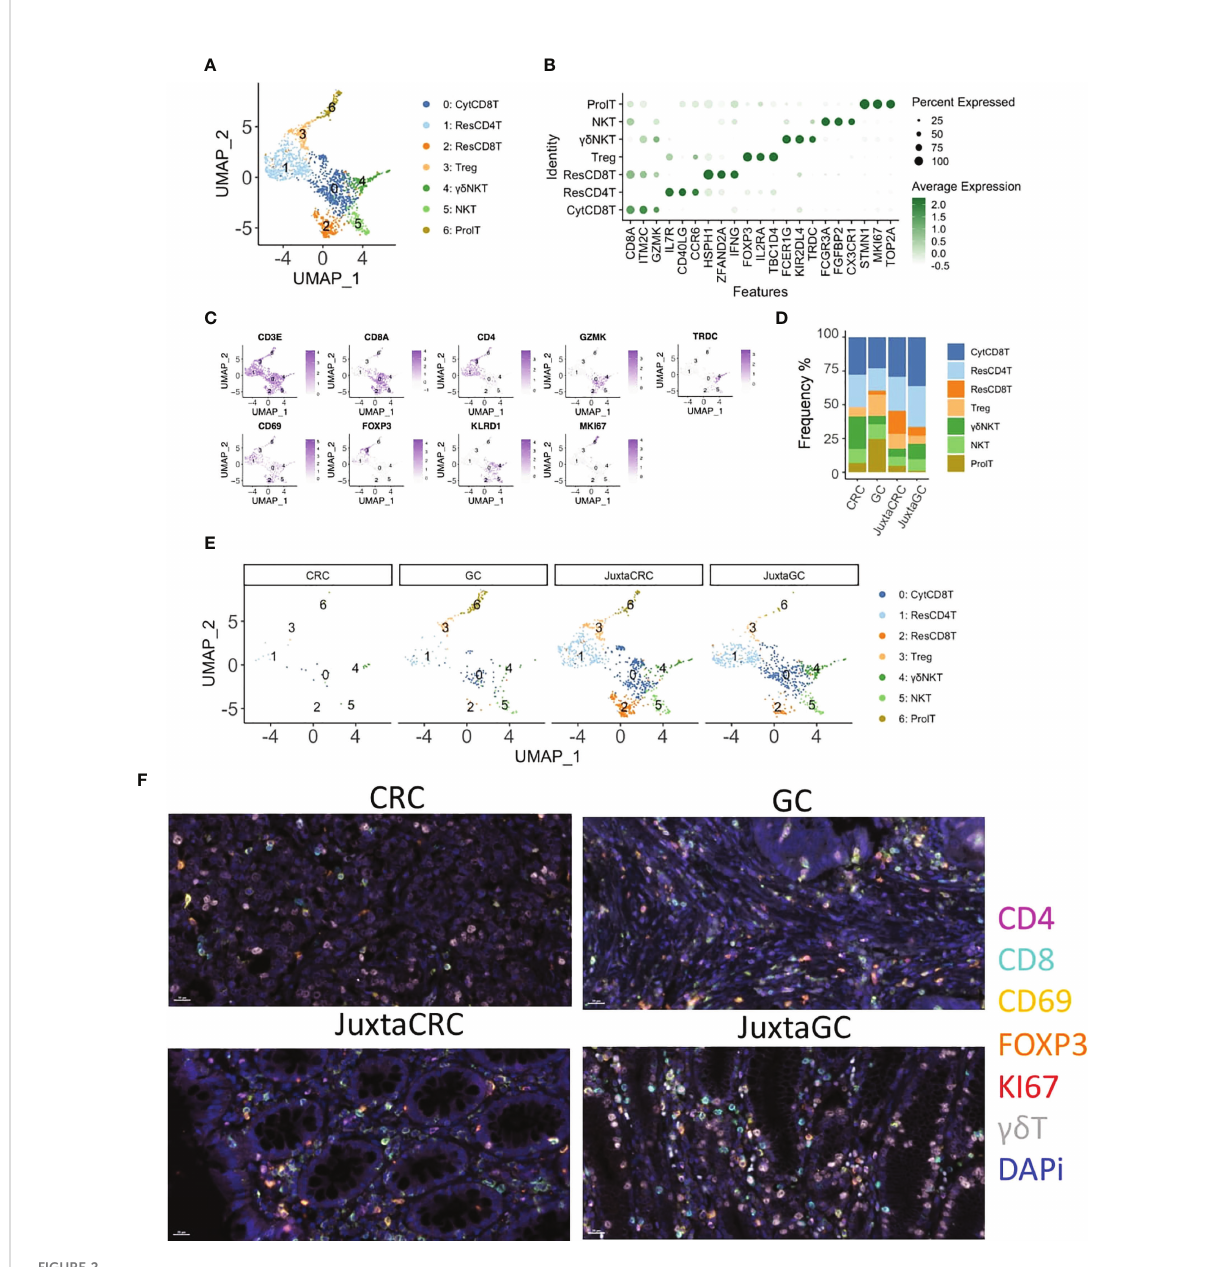
FIGURE 2 T-cell diminishment in CRC. (A) UMAP plots of the T-cell population reveal seven cell subsets, namely, cytotoxic CD8 + T cells (CytCD8T), CD4 T cells (ResCD4T), resident CD8+ T cells (ResCD8T), regulatory T cells (Treg), gamma delta NK T cells ( gd NKT), NK T cells (NKT), and proliferating T cells (ProlT). (B) Dot plot shows the top three cluster-speci fi c feature genes, dot size indicates the percent expressed, and the level of color indicates the average expression. (C) Feature plots show the expression pattern of the diagnostic marker genes for cluster annotation, including CD3E (T cells), CD8A (CD8 + T cells), CD4 (CD4 + T cells), GZMK (CD8 + T cells), TRDC (gamma delta T cells), CD69 (resident T cells), FOXP3 (Treg), KLRD1 (NK cells), and MKI67 (proliferating cells). (D) Bar plot displays the population of each T-cell subset across samples. (E) UMAP plots of the T-cell population spat by samples. (F) mIHC staining of CD4 (magenta), CD8 (cyan), CD69 (yellow), FOXP3 (orange), KI67 (red), gd T (white), and DAPi (blue) in CRC, GC, JuxtaCRC, and JuxtaGC